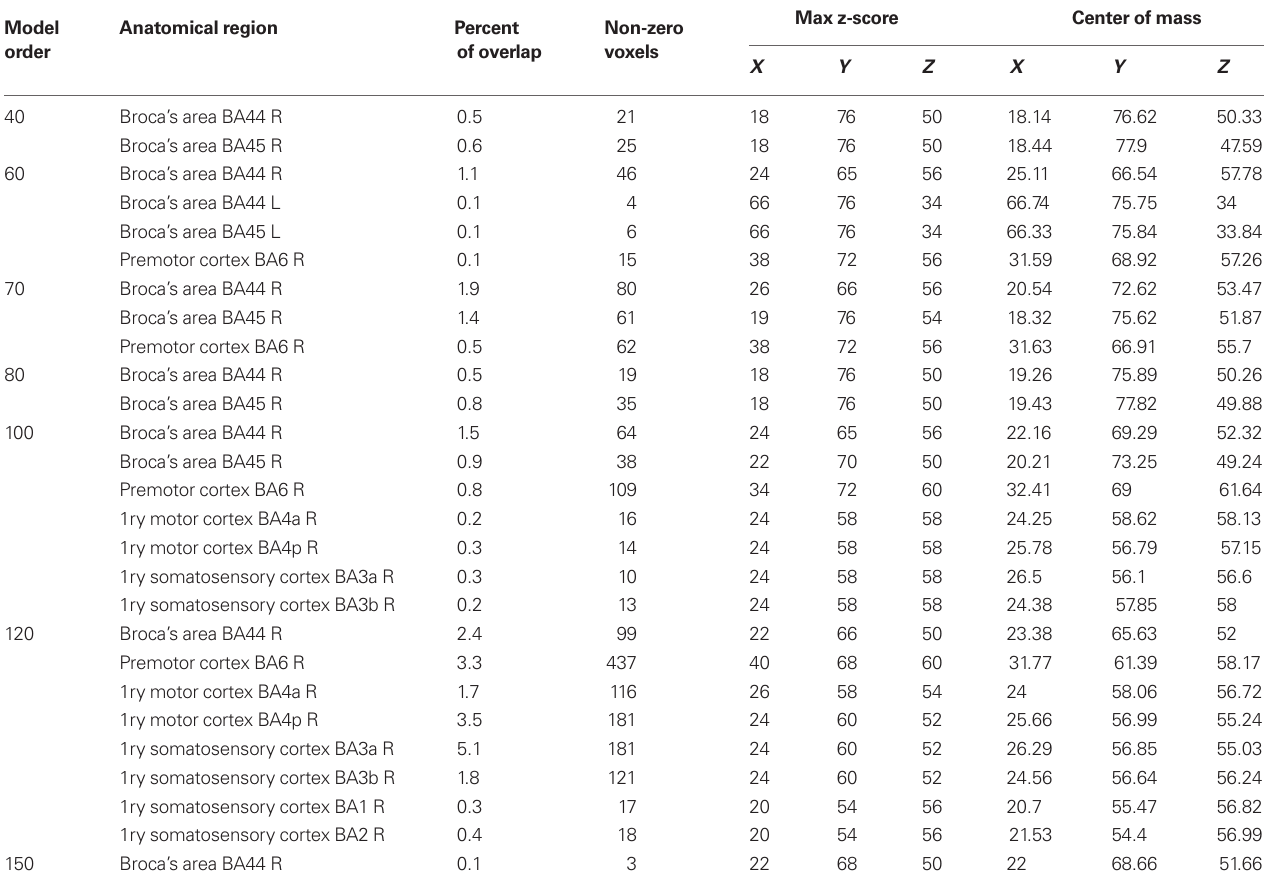
Table 3 | SAD functional connectivity differences in the motor cortex at all estimated ICA model